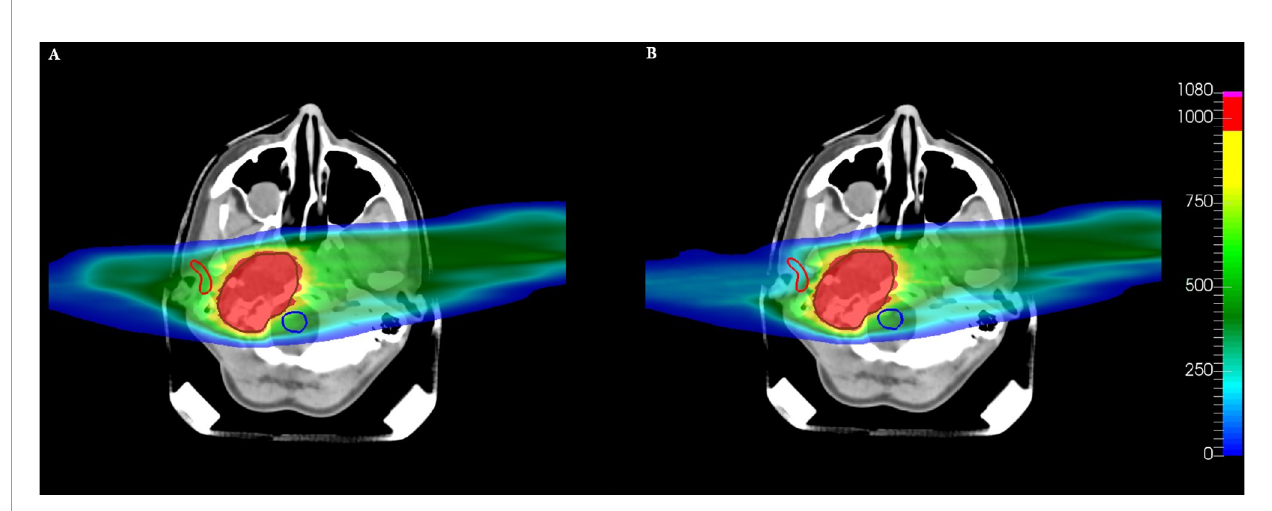
FIGURE 6 | Comparison of dose distributions on a CT slice for patient plan 335, obtained with (A) voxel-dose-based and (B) generalized equivalent uniform dose (gEUD)-based optimization. The target (brown contour), the right parotid (red contour), and the brainstem (blue contour) are shown. The dose levels are plotted in per mil of the prescribed